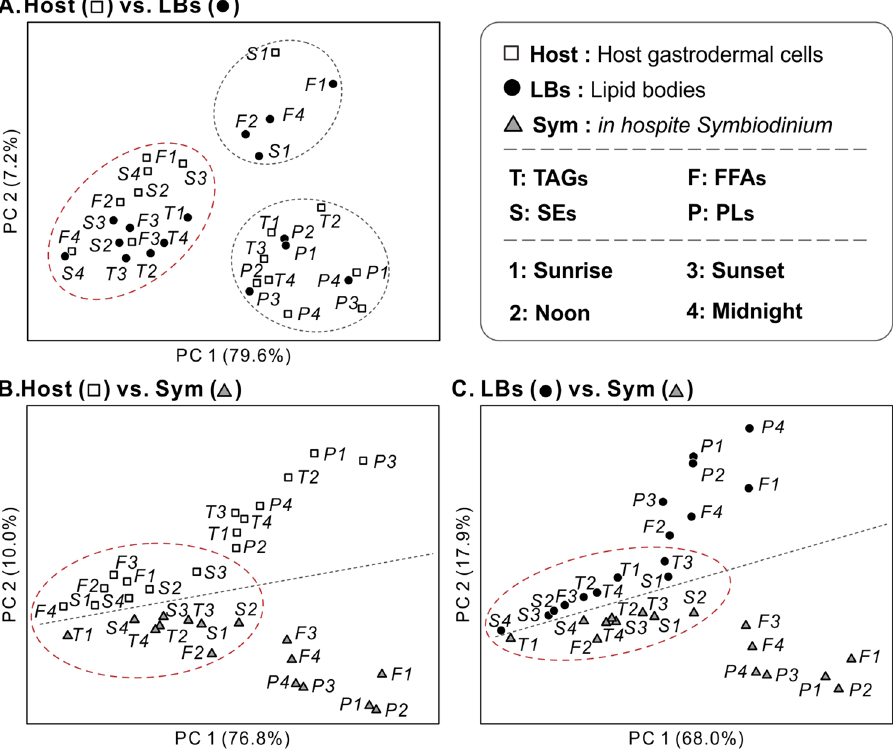
Figure 5. Inter-compartmental lipid involvement. Principal components analysis (PCA) of fatty acid (FA) moieties in individual lipid species within and across multiple compartments of the Euphyllia glabrescens- Symbiodinium endosymbiosis. ( A ) host gastrodermal cells (“Host,” hollow squares) versus lipid bodies (“LBs,” solid circles) ( B ) host (hollow squares) versus in hospite Symbiodinium (“Sym,” gray triangles) ( C ) LBs (solid circles) versus Sym (gray triangles) across the diel cycle (1: sunrise, 2: noon, 3: sunset, and 4: midnight). T: TAGs, F: FFAs, P: PLs, and S: SEs (see main text for full names of these lipids). The red dash circles presented to cluster the closely related of lipid species and strongly similarity of FA moieties after pairwise comparison of PCA across multiple